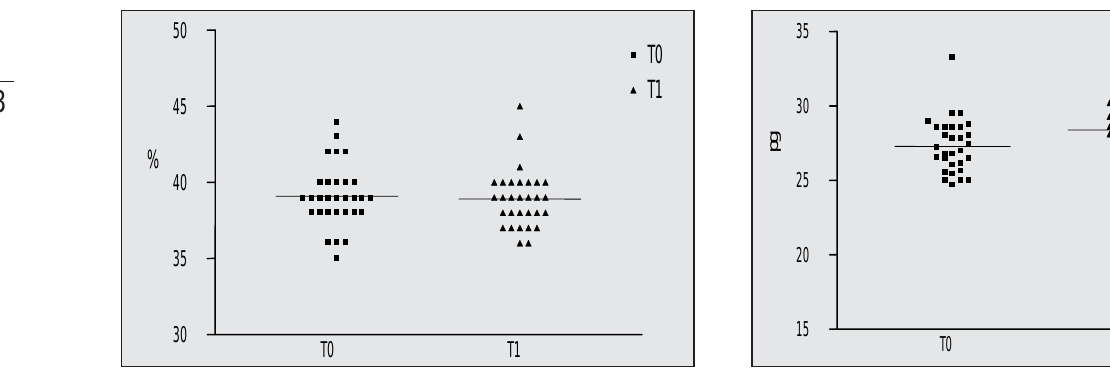
Figura 3 – Distribuição dos valores de hematócrito das pacientes antes (T0) e após (T1) a reposição hormonal. Não houve diferença estatisticamente significativa